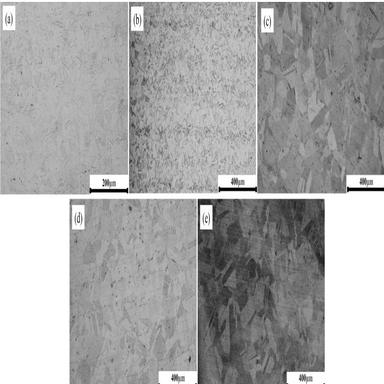
Metallography of industrial 304 stainless steel with different grain sizes at 1050 ◦C: (a) untreated industrial 304 stainless steel (b) annealed for 30 min (c) annealed for 60 min (d) annealed for 120 min (e) annealed for 240 min.